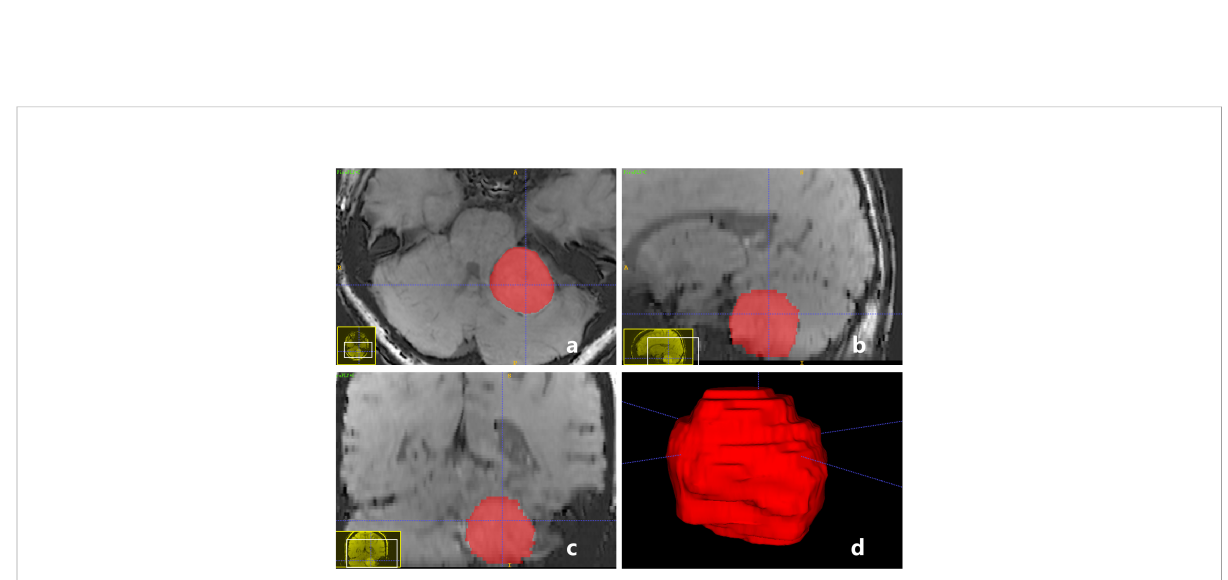
FIGURE 4 A-59-year-old woman with a pathologically con fi rmed meningioma in her left cerebellopontine angle area after surgical resection. ROI of tumor was drawn on CE-T1WI FSBB images slice-by-slice on the original axial (A) , reconstructed sagittal (B) , and reconstructed coronal (C) images, to obtain a 3D reconstructed volume of the tumor automatically (D) . Tumor volume = 16.95 (cm 3 ), VDI = 0.27, MDI =